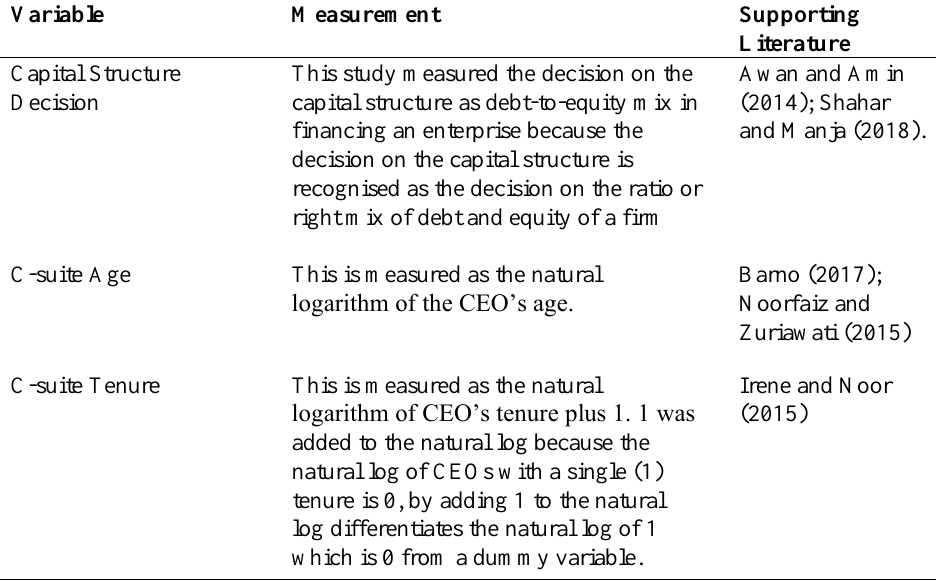
Table 1: Measurement of Variables Variable